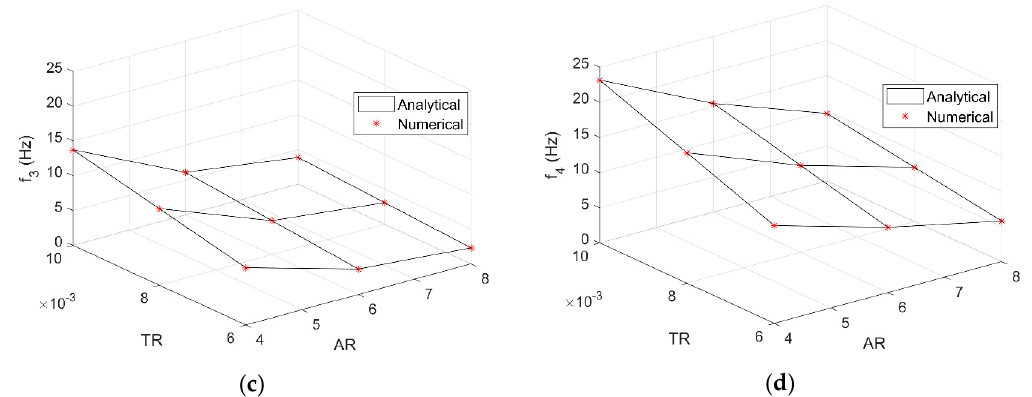
Figure 5. First ( a ), second ( b ), third ( c ) and fourth ( d ) vibration frequencies for all considered wings. Table 2. FEM and analytical natural vibration modes, for all considered wings.